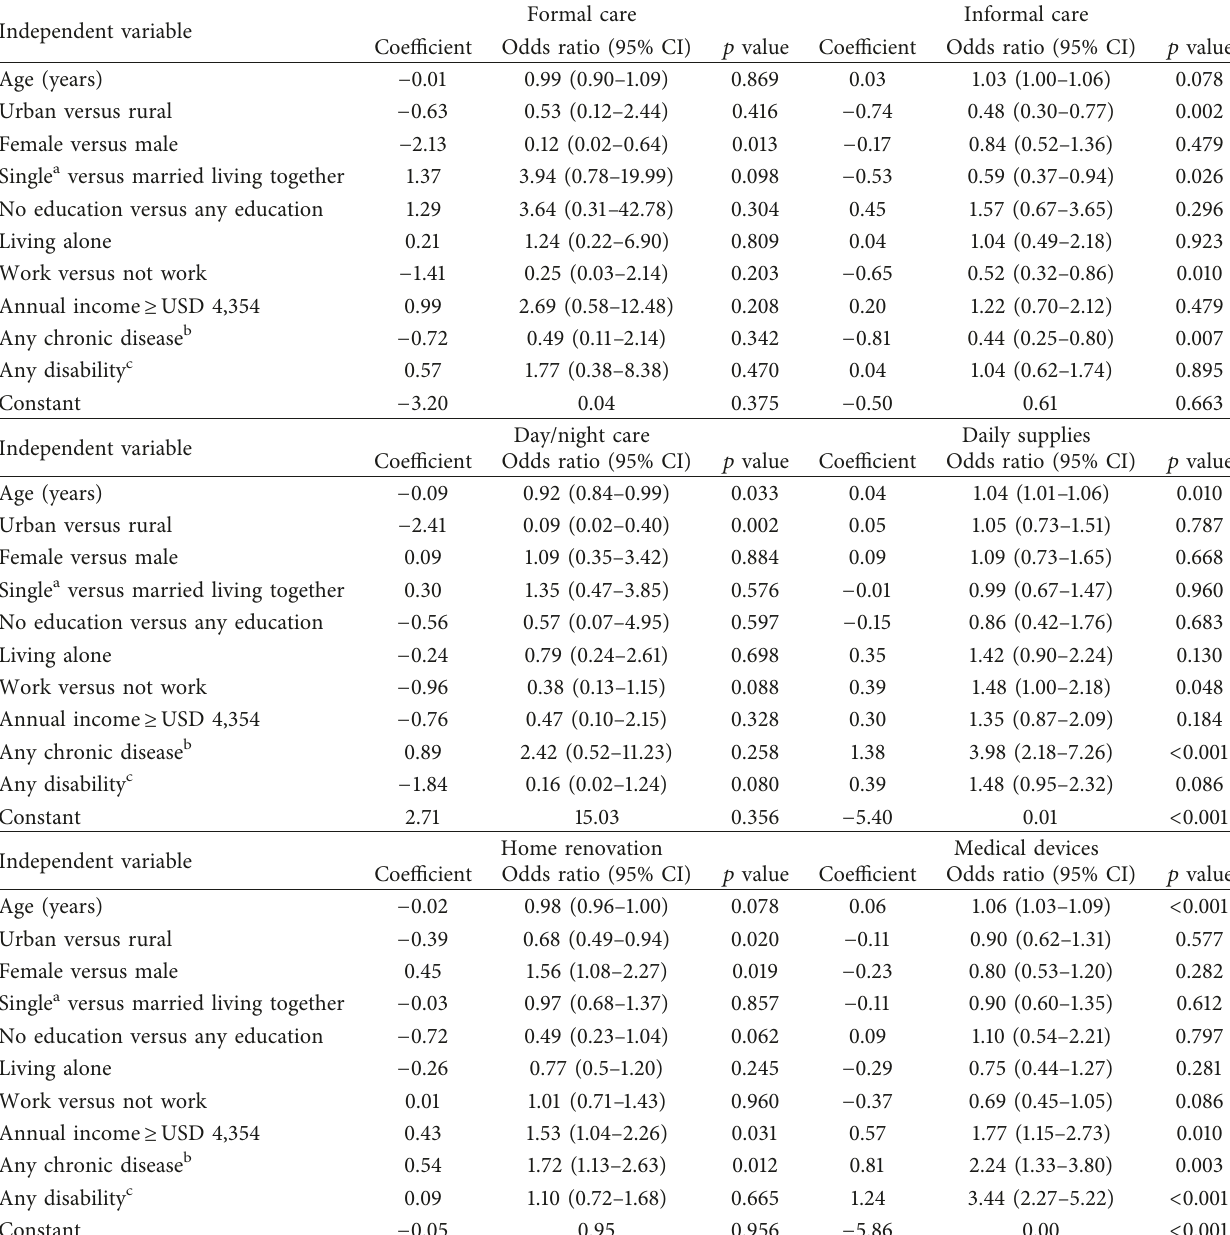
Table 6: Factors associated with LTC utilization from logistic regression